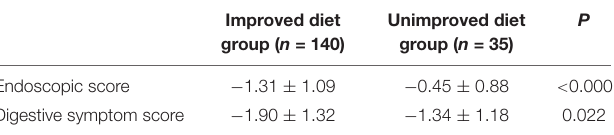
TABLE 4 | Comparison of the difference between the endoscopic performance score and the symptom score of the diet improvement group and the diet non-improvement group at 1 year after dietary guidance.